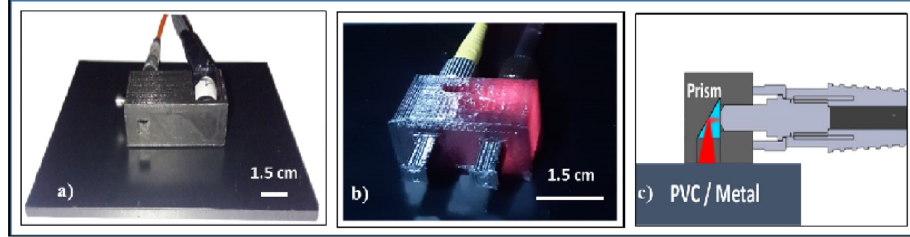
Fig 1. Probe for optical fibers. a) TD-NIRS probe; b) DCS probe (FILOALFA); c) probe’s